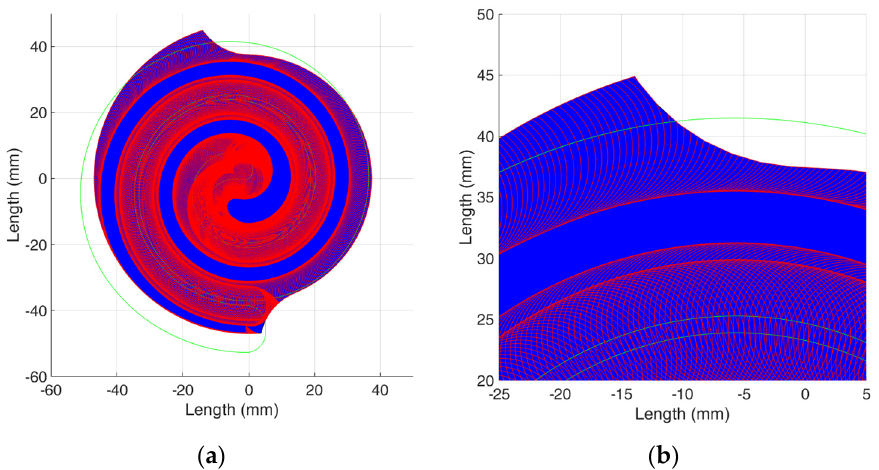
Figure 1. Cutting area intersected by tooth paths and scroll workpiece: ( a ) full view, ( b ) zoomed-in view.